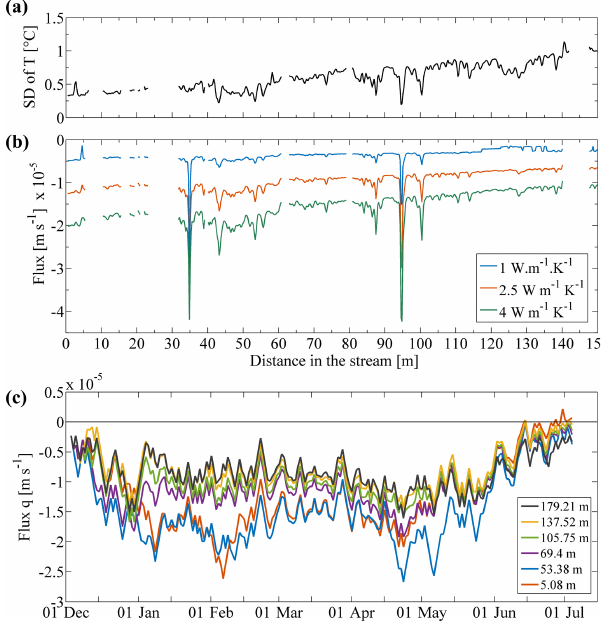
Figure 6. (a) Profile of the SD of the streambed temperature calcu- lated over the experiment duration for each measurement point lo- cated along the FO cable and deployed in the wetland area. (b) Pro- files of mean fluxes estimated over the experiment duration us- ing the FLUX-BOT model from DTS measurements collected in streambed sediments in the wetland area, considering three values of thermal conductivity (negative values indicate an upward wa- ter flux). (c) Temporal evolution of the estimated flow considering λ = 2.5Wm − 1 K − 1